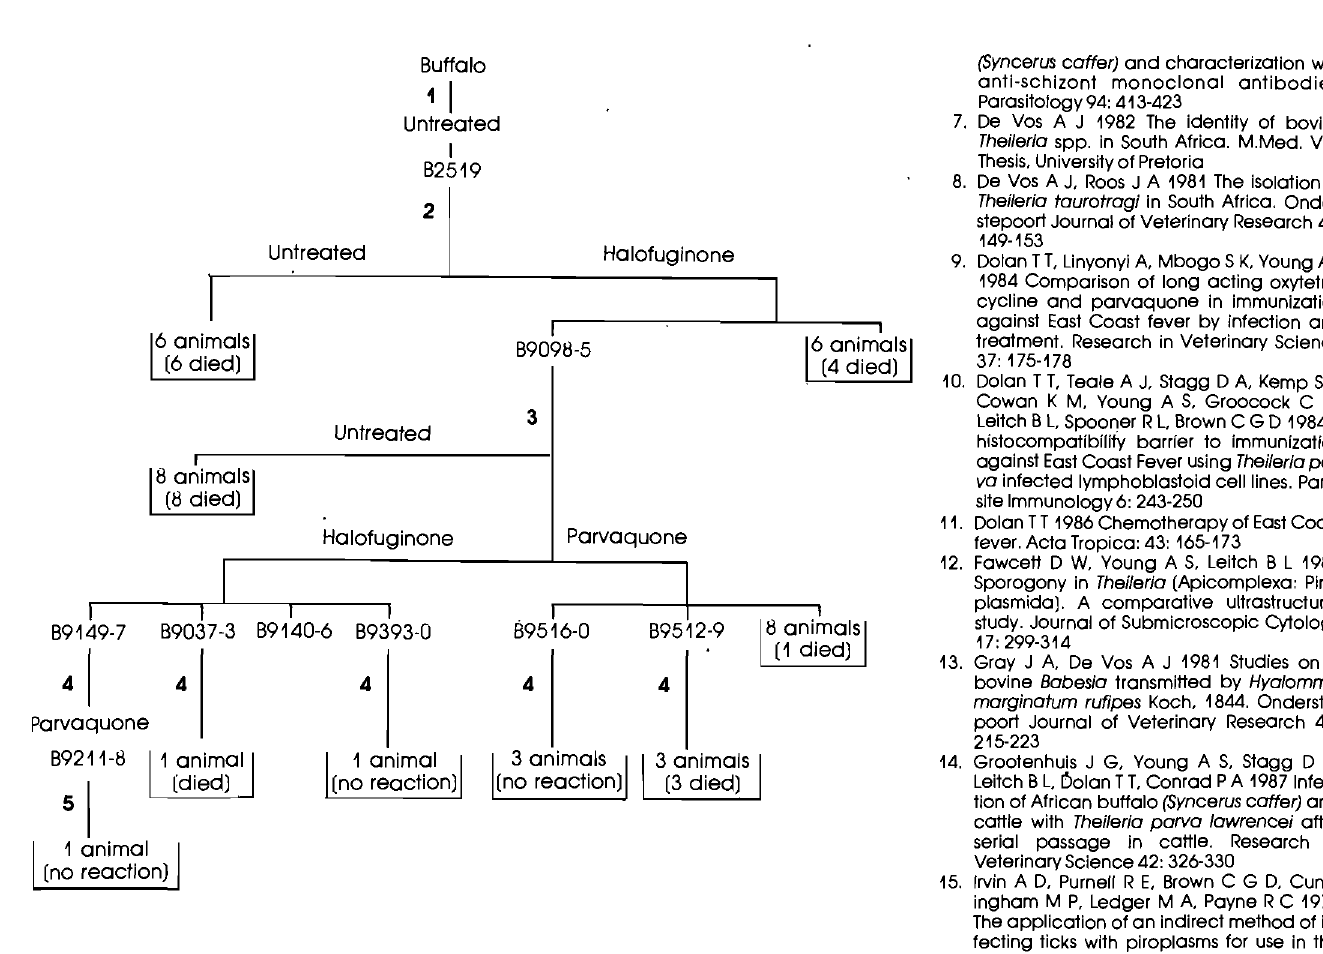
Fig. 3: Schematic representation of the transmission of Theileria parva lawrencei buffalo isolate (Hluhluwe 3) from cattle to cattle with Rhipicephalus appen diculatus. Each tick-passage is indicated by numerals 1 to